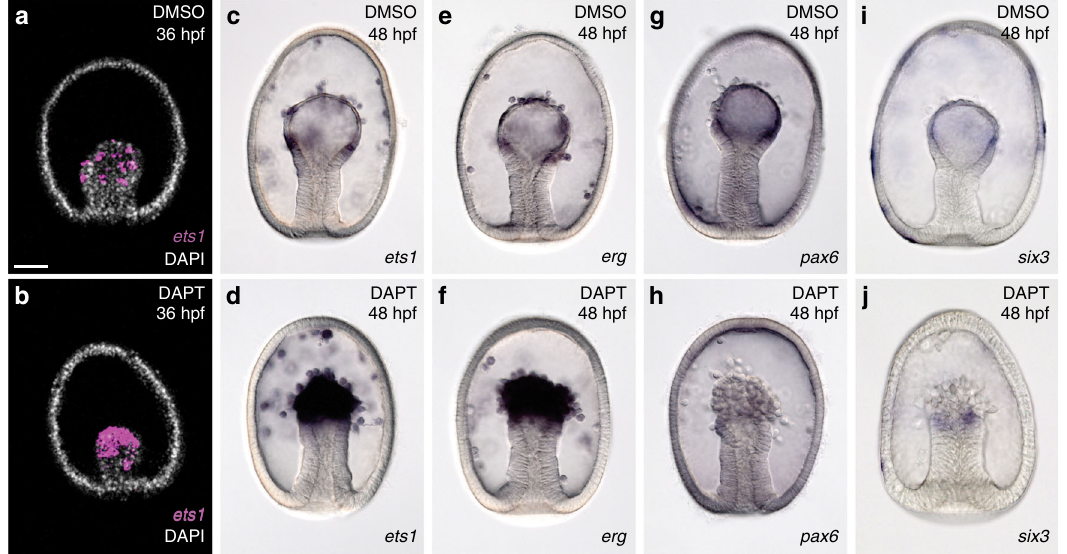
Fig. 4 Testing the lateral inhibition model of mesodermal subtype segregation. The expression of ets1 transcript (magenta) appears in a salt-and-pepper distribution throughout the mesoderm at 36 h post fertilization (hpf) by fl uorescent WMISH ( a ) with DAPI stained nuclei (white). Treatment with the Notch inhibitor DAPT beginning at the 2-cell stage results in a uniform expression of ets1 in this territory ( b ). By 48 hpf, the mesenchyme cells expressing ets1 and erg ( c , e ) ingress into the blastocoel while cells that do not ingress express pax6 and six3 ( g , i ). DAPT treatment results in an increase in cells expressing ets1 and erg ( d , f ) and a reduction in cells expressing pax6 and six3 ( h , j ). There is also a consistent morphological shift with an increase in the number of ingressing cells and a reduction in the epithelium when Notch signaling is blocked. Data shown in ( c – j ) are colorimetric WMISH. Data are representative of two biologically independent experiments consisting of at least ten embryos each. Scale bar represents 50 μ m; applicable to all images in the